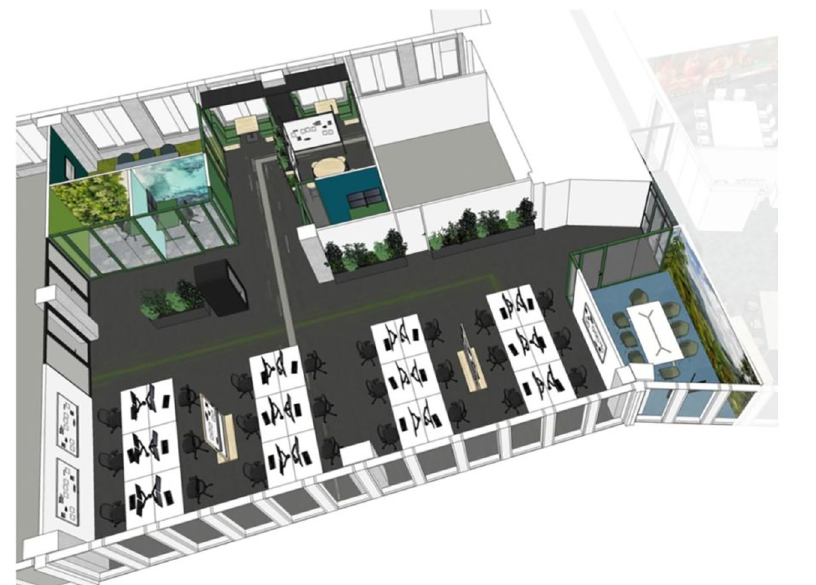
Fig 5. Activity-based design. Digital render of the Activity-based design.